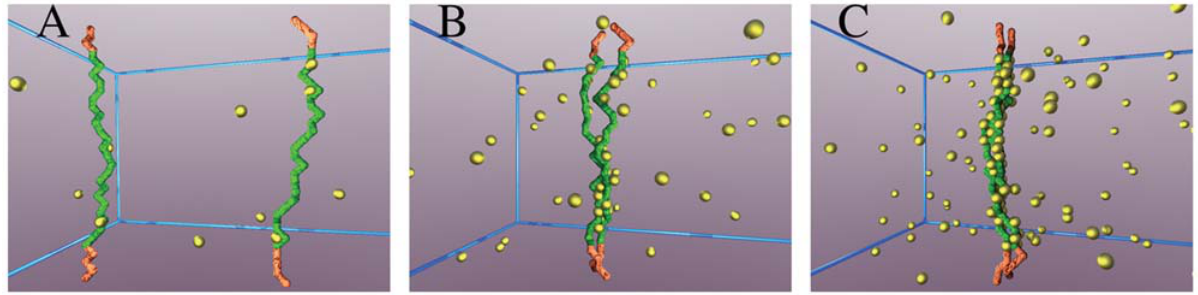
Figure 2. Typical equilibrium configurations. Pictures of typical configurations of our model system at thermodynamic equilibrium (here E =1.2 kT ). (A) Polymers conformation for a value of the concentration of molecular factors (MFs) c =0.3% (Brownian phase, see Figure 4), (B) for c =2.5% (crossover region), (C) for c =5% (Pairing phase). The polymers, representing Xic segments responsible for pairing, are formed by a set of linked beads (not visible because of magnification); green beads are the binding sites (BSs) interacting with the floating molecular factors (MFs, yellow beads). The BSs form a cluster of n 0 =24 sites, which is of the order of magnitude of the clustered CTCF binding sites found in the Tsix/Xite region (see Figure 1). MFs can bind more than a single BS at the same time, as much as CTCF molecules which have multiple DNA binding domains.